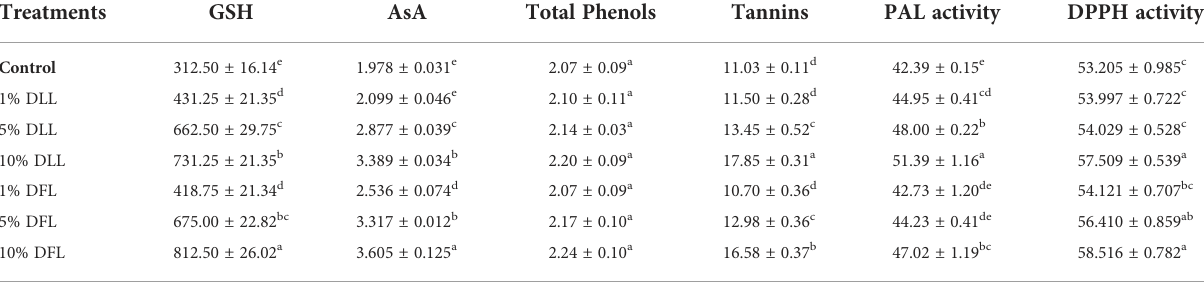
TABLE 3 Reduced glutathione (nM g -1 fr wt), ascorbic acid, total phenols, tannins (mg g -1 fr wt), phenyl alanine ammonia lyase (nM trans- cinnamic acid min -1 mg -1 protein), and total antioxidant (percent) activity in leaves of Triticum aestivum L. plants raised using sand substrate (25 DAS) treated with leachates of dry leaves and fl owers of Tagetes erecta